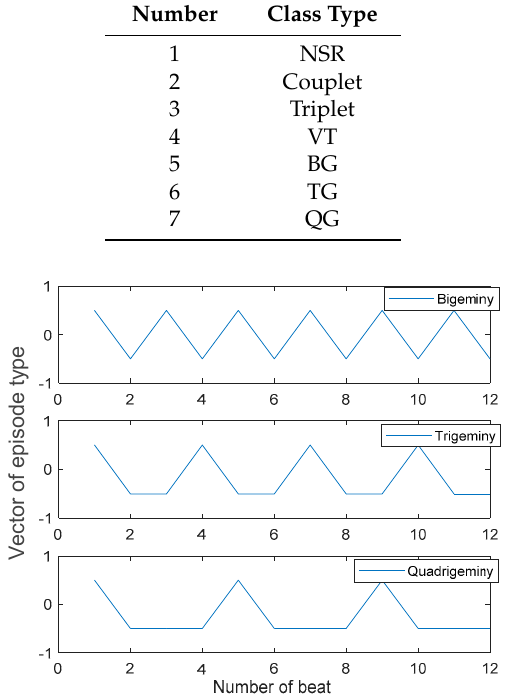
Figure 11. Vector of episode type of three segments with BG, TG, and QG episodes which have 12 beats (Plotted after mean removal).